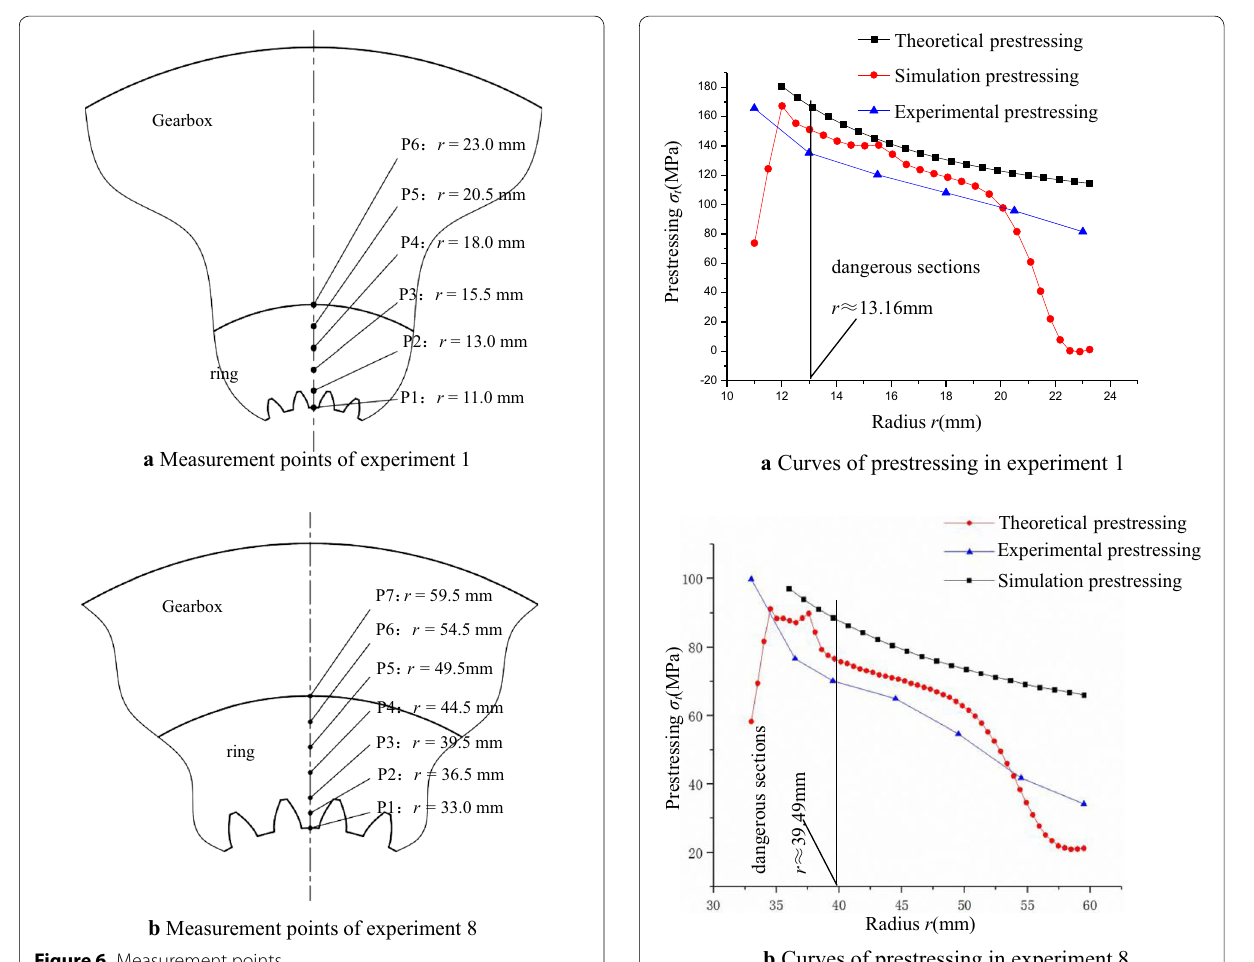
Figure 6 Measurement points